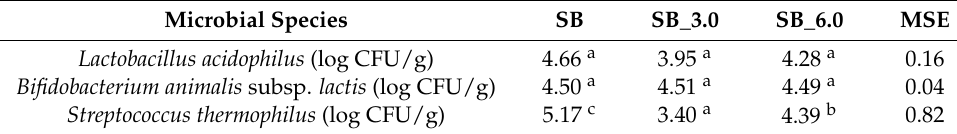
Table 3. Viable counts of bacteria in soy beverages with acai powder. Microbial Species SB SB_3.0 SB_6.0 MSE Lactobacillus acidophilus (log CFU/g) 4.66 a 3.95 a 4.28 a 0.16 Bifidobacterium animalis subsp. lactis (log CFU/g) 4.50 a 4.51 a 4.49 a 0.04 Streptococcus thermophilus (log CFU/g) 5.17 c 3.40 a 4.39 b